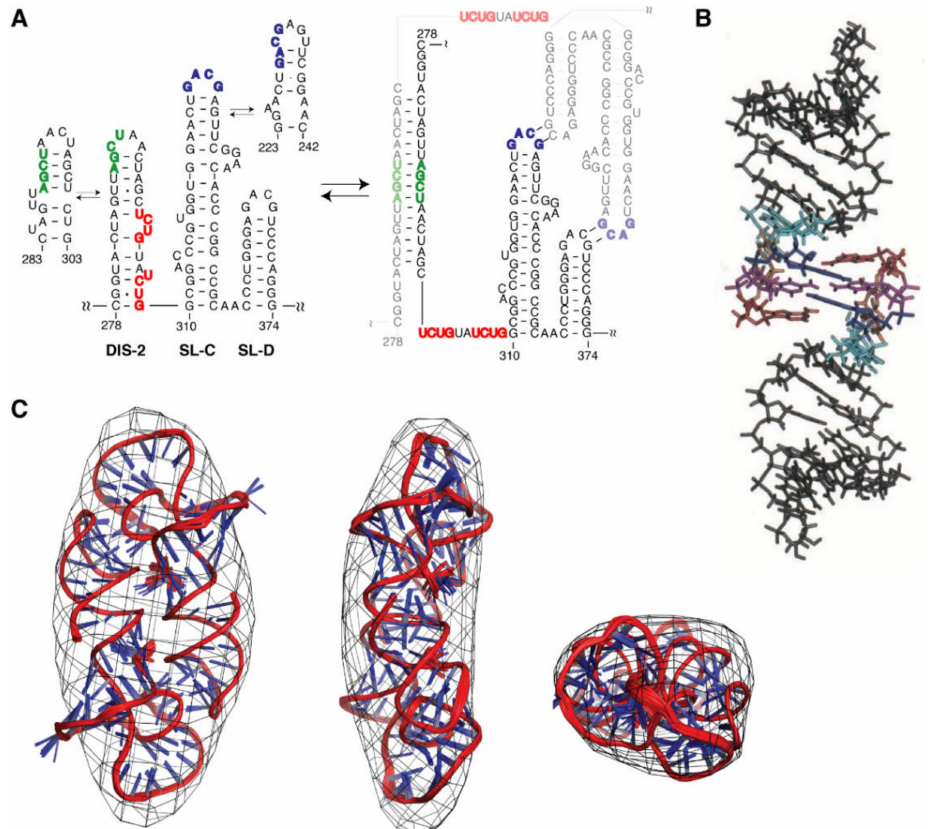
Figure 13. Dimerization-dependent structure of the MoMuLV minimal packaging signal. ( A ) Left: Secondary structure of monomeric m Ψ and the base pairings observed at equilibrium for DIS-2 and SL-C. Right: Base pairings in the dimeric form of m Ψ . The palindromic sequences required for dimer formation are shown in green (DIS-2) and blue (SL-C and SL-D). NC-binding UCUG elements are shown in red. ( B ) The NMR structure of the 18-nt SL-D kissing duplex. ( C ) Superposition of the cryo-electron tomography densities and the NMR ensemble structures of [ Ψ CD ] 2 . Panels ( A , C ) reproduced from [320], and panel ( B ) from [321], with